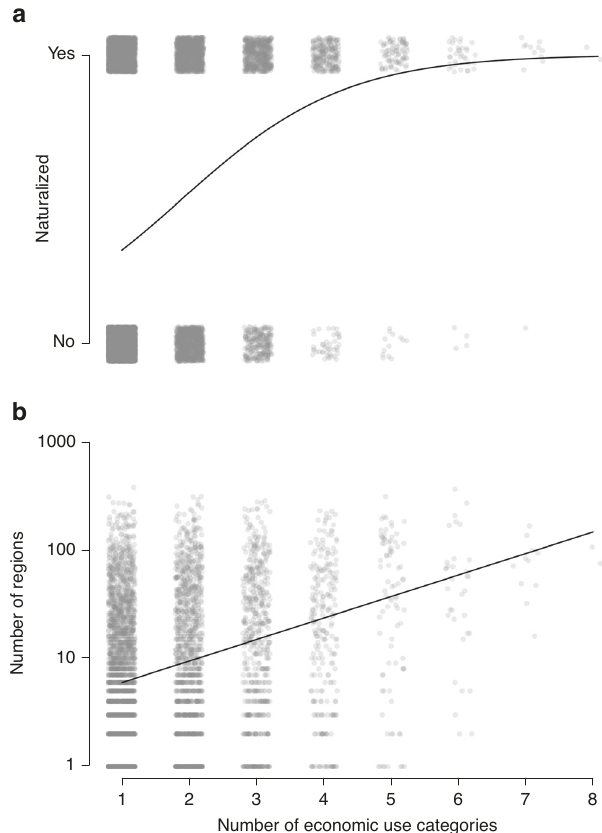
Fig. 3 Relationship between the number of economic uses and naturalization success. a Naturalization incidence of economic plants. b Naturalization extent (i.e., the number of GloNAF regions) for those economic plants that have become naturalized. The data points have been jittered to increase visibility. The fi tted lines are ( a ) from a binomial GLM, and ( b ) from a Kendall – Theil Sen Siegel nonparametric regression.